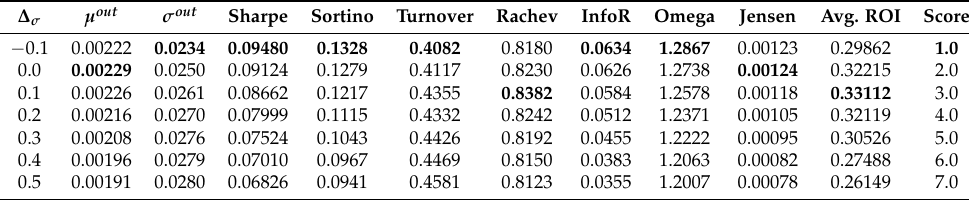
Table 14. ETF: out-of-sample performance results for the KP R strategy by varying ∆ σ (with ∆ γ = 0.3).